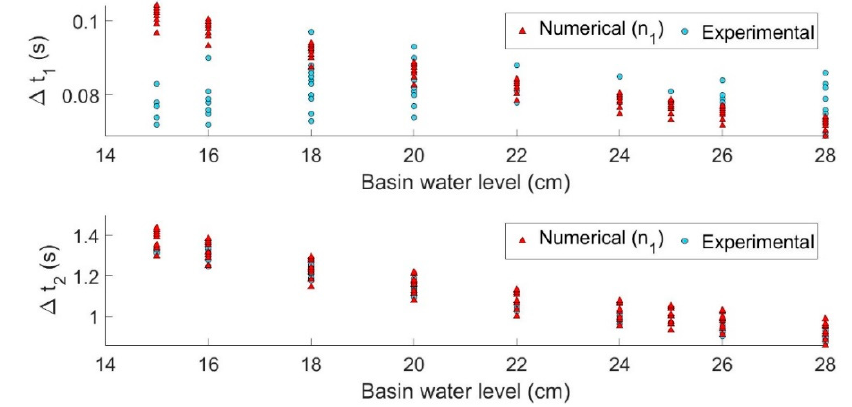
Figure 4. Propagation times of the bore derived from WL experimental and synthetic records for different values of the initial water height h 0 . For each value of h 0 , the value of h 1 has been varied from 1 to 8 mm in the numerical runs. The adopted Manning’s coefficient is n 1 = 0.0125 s m − 1/3